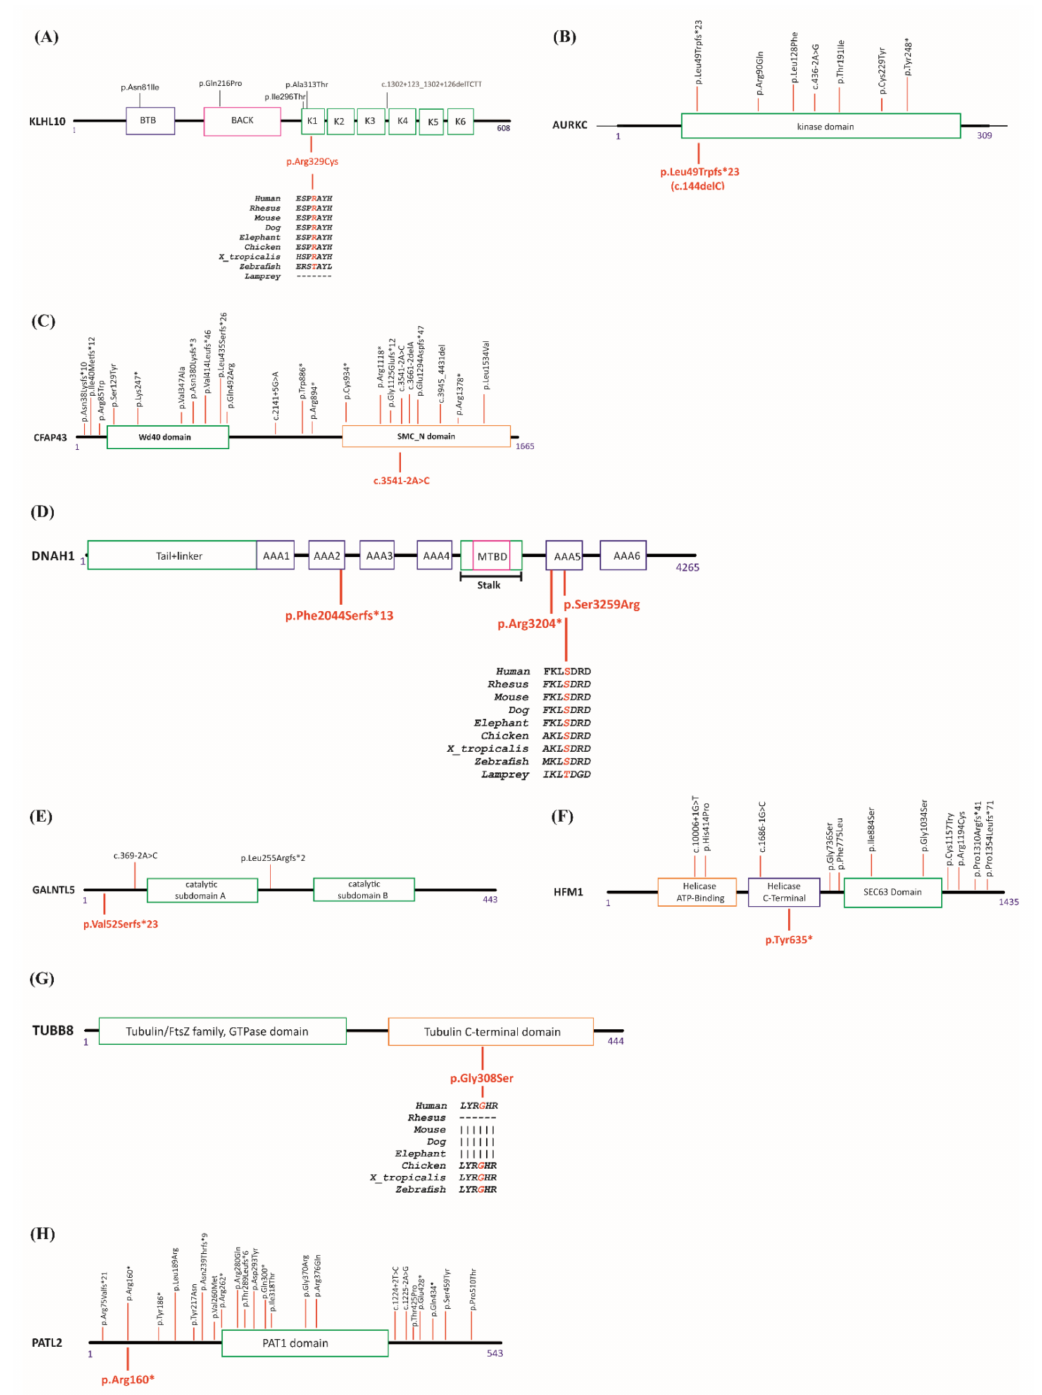
Figure 1. Schematic representation of ( A ) KLHL10, ( B ) AURKC, ( C ) CFAP43, ( D ) DNAH1, ( E ) GALNTL5, ( F ) HFM1, ( G ) TUBB8, and ( H ) PATL2 proteins and their published mutations. Published mutations are indicated on top, while mutations identified in this study are shown at the bottom. Since more than 40 mutations have been identified for TUBB8 and DNAH1, identified mutations are not shown on the figure. Details of mutations on relative genes are given in Supplementary Table S4. Protein sequence alignments for different species are shown for missense mutations identified in this